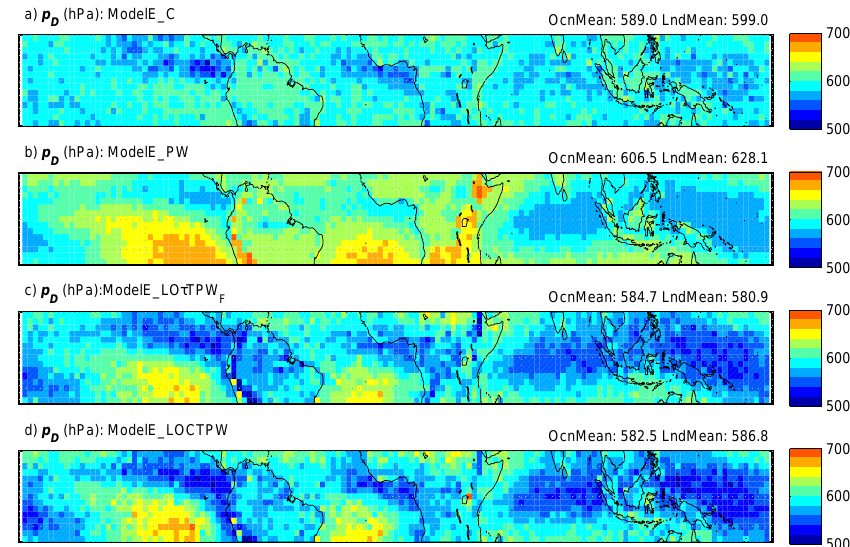
Fig. 12. Approximated p D (height of peak HDO sensitivity) for four representative categorizations.